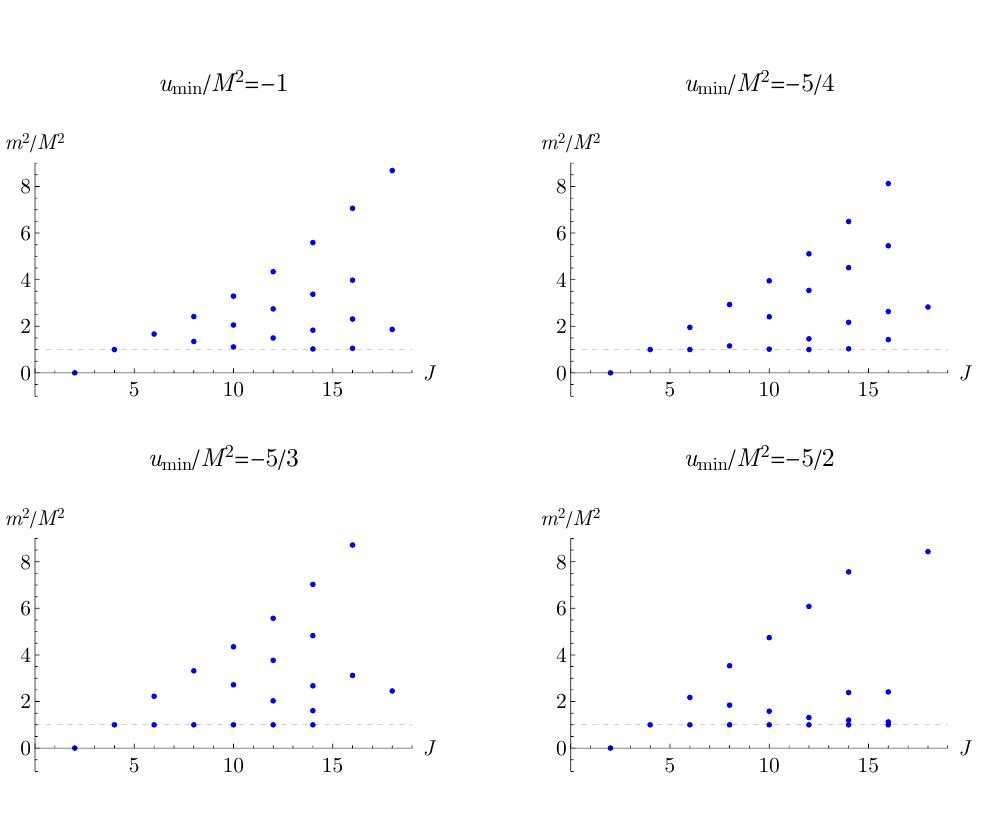
Figure 10 . Extremal spectra for the bound that minimizes g 2 in D = 6 , computed using different wavefunctions with different ranges u ∈ [ u min , 0] . As u min gets more negative, the spectrum appears to simplify, with approximately linear Regge trajectories at m 2 ∼ M 2 ( J − 2) / 2 and m 2 = M 2